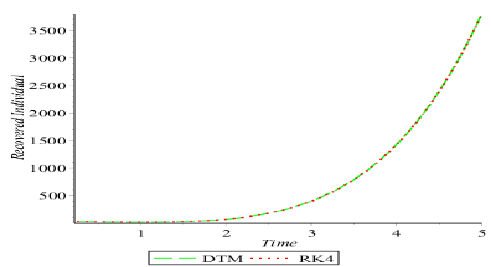
Figure 5: Solution of Hygienic Infected Individuals